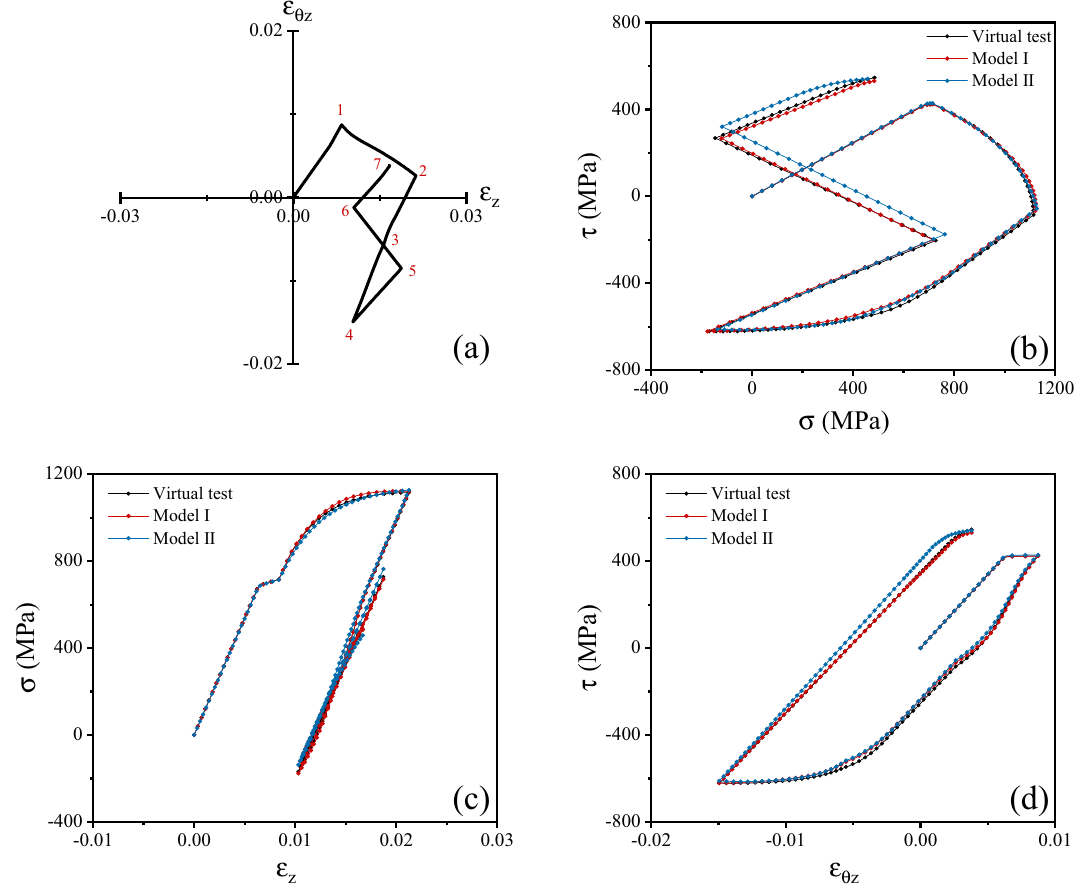
Figure 7. ( a ) One of the random strain histories used to assess the surrogate models; ( b ) stress history corresponding to the strain history in ( a ), including the predictions of the surrogate models; ( c ) normal stress versus strain history and predictions of the surrogate models; ( d ) shear stress versus strain history and predictions of the surrogate